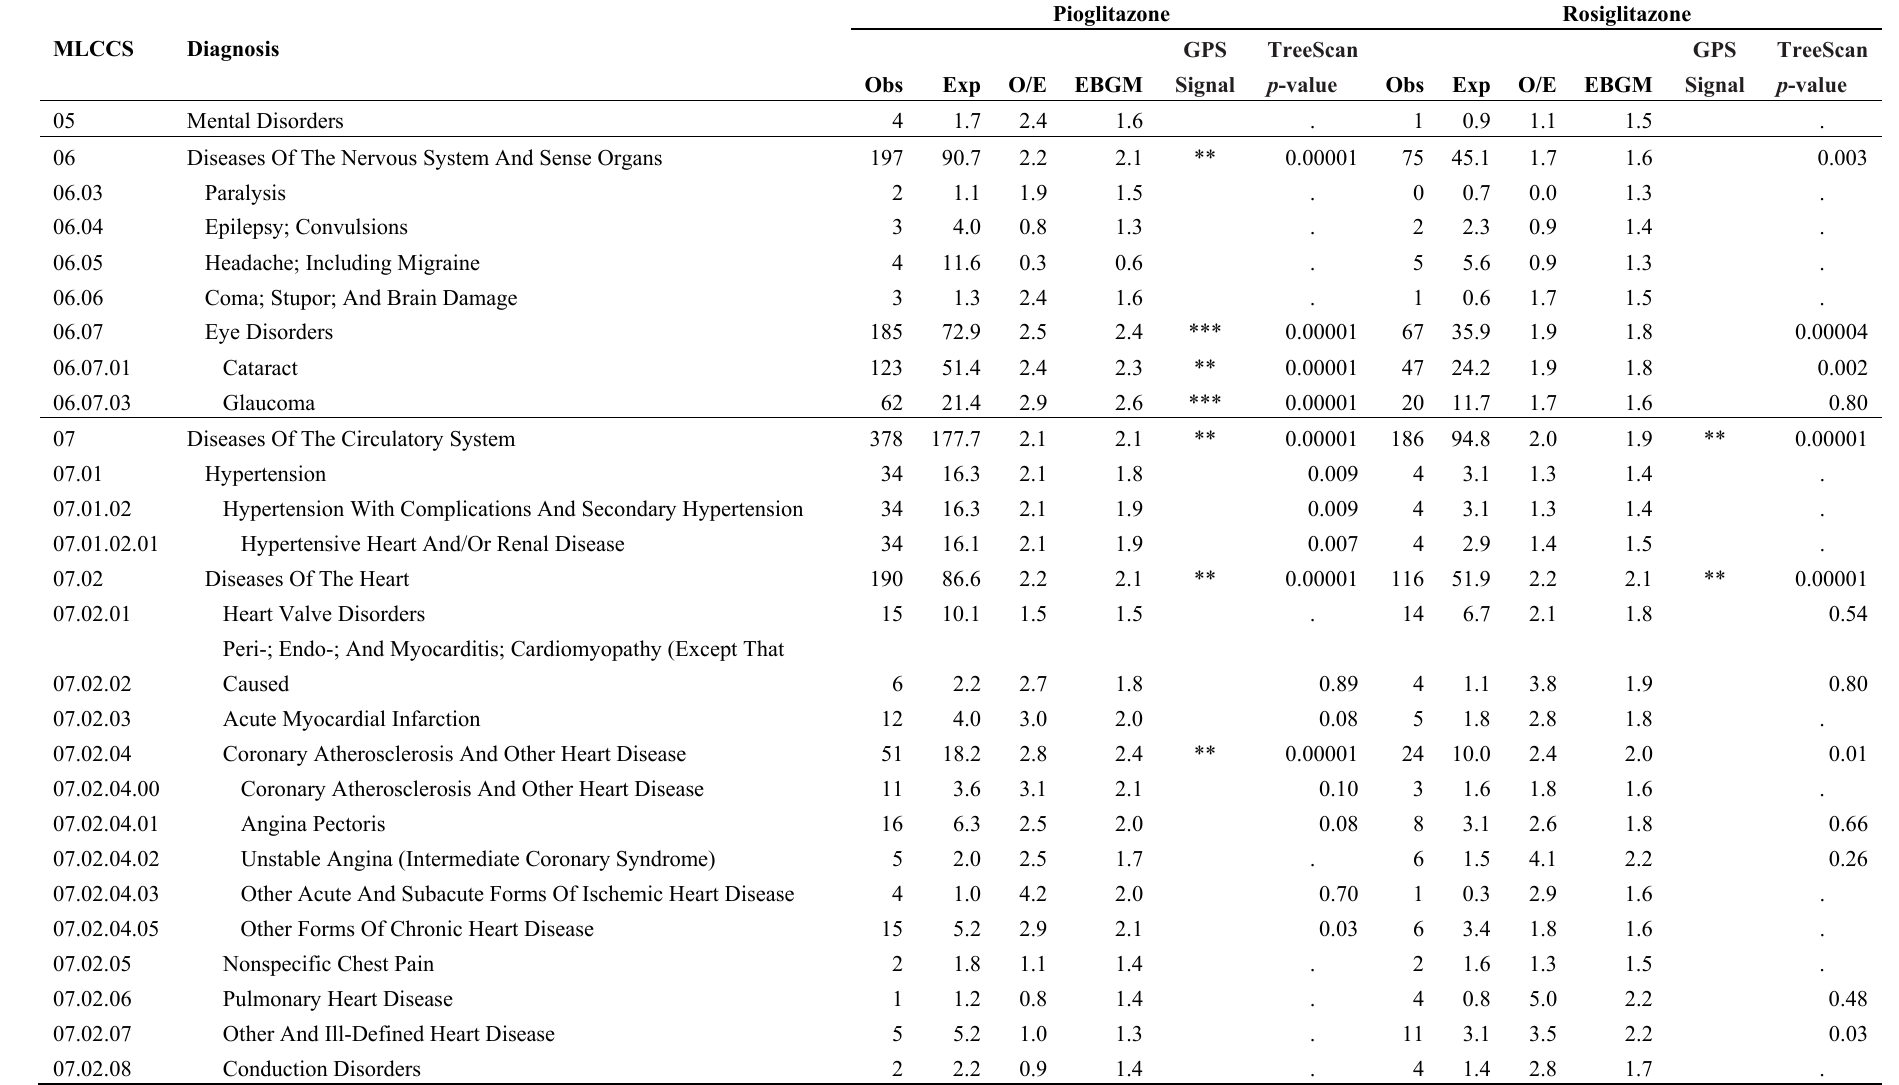
Table 3 . Results for pioglitazone and